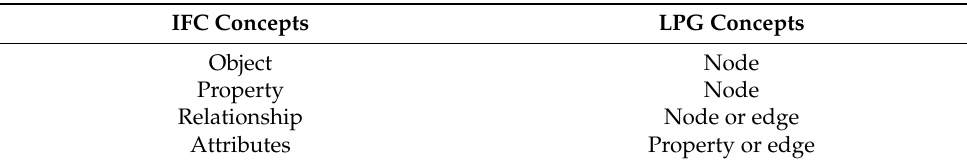
Table 1. Concept mapping between IFC and